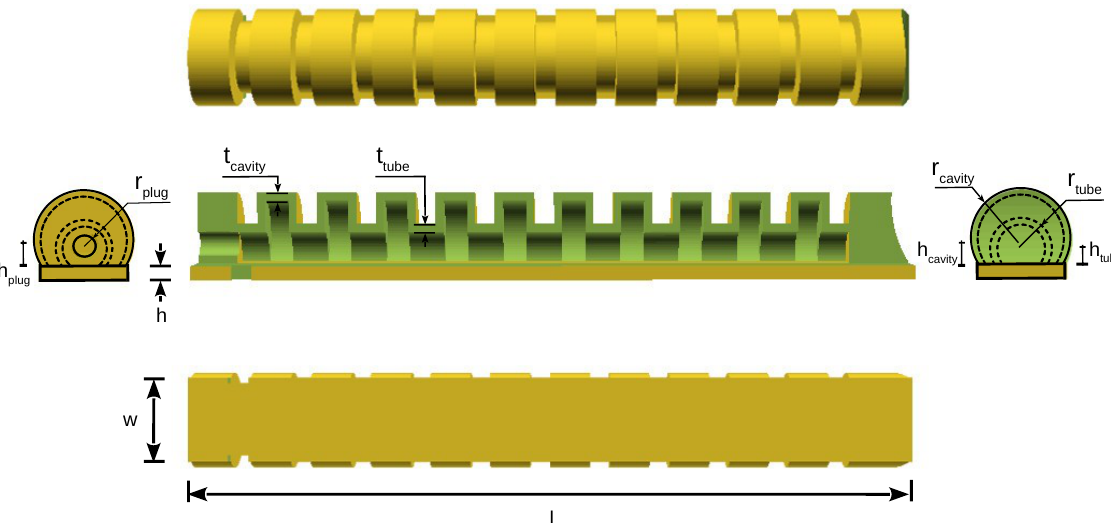
Figure 2. Parametric soft actuator